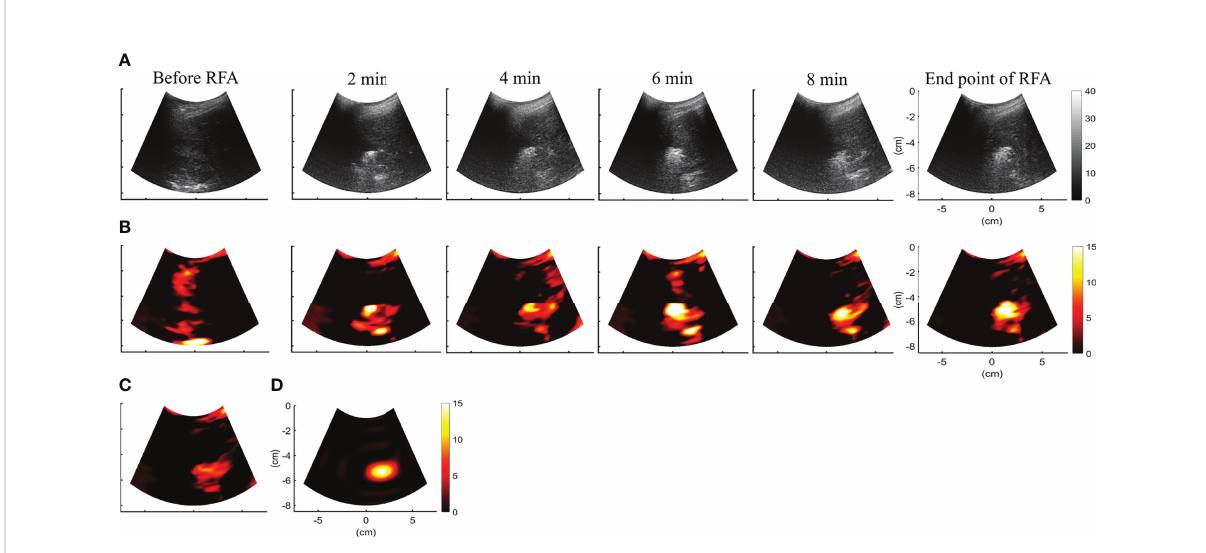
FIGURE 4 (A, B) depict the B-mode and CBE | h temporally combined as (C) CBE | h information related to nonablated tissues, and artifacts were also not found to enable estimations of the ablation